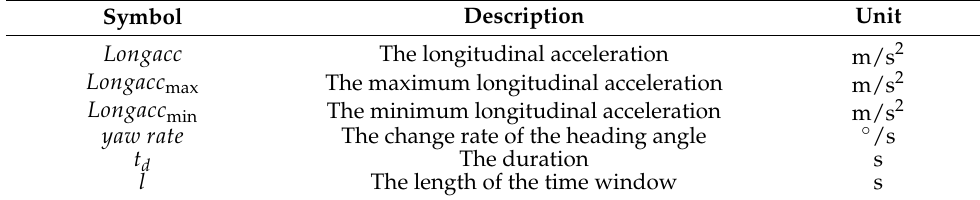
Table 3. Notation and description for variables